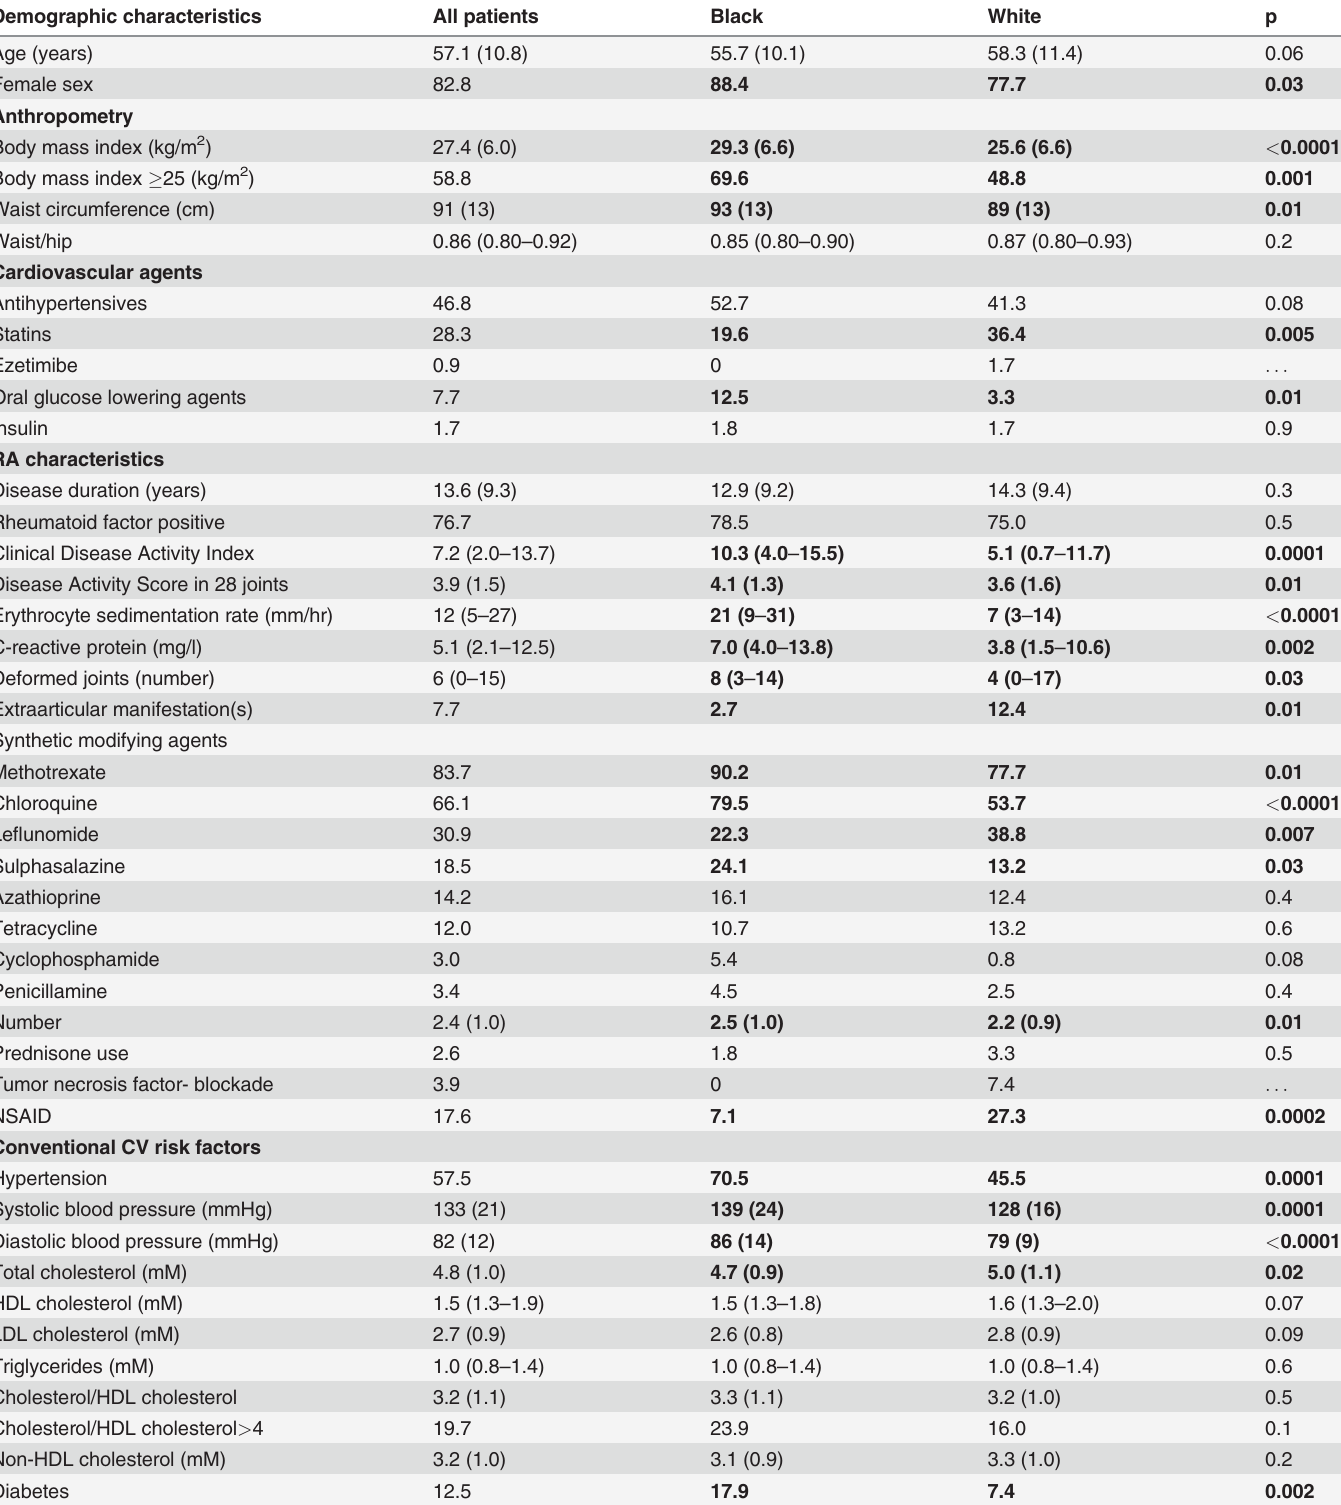
Table 2. Recorded characteristics in all 233 and 112 black and 121 white patients with RA. Demographic